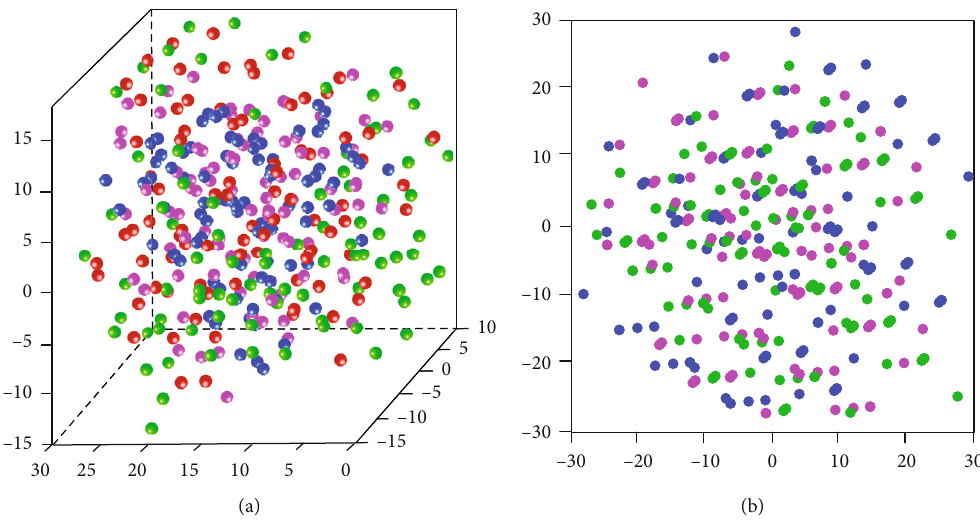
Figure 3: Datasets and dimensionality reduction